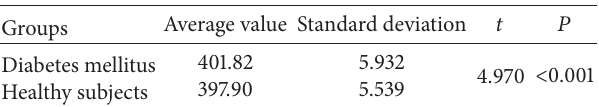
Table 3: The ORP value of urine of 30 diabetes mellitus and 30 healthy